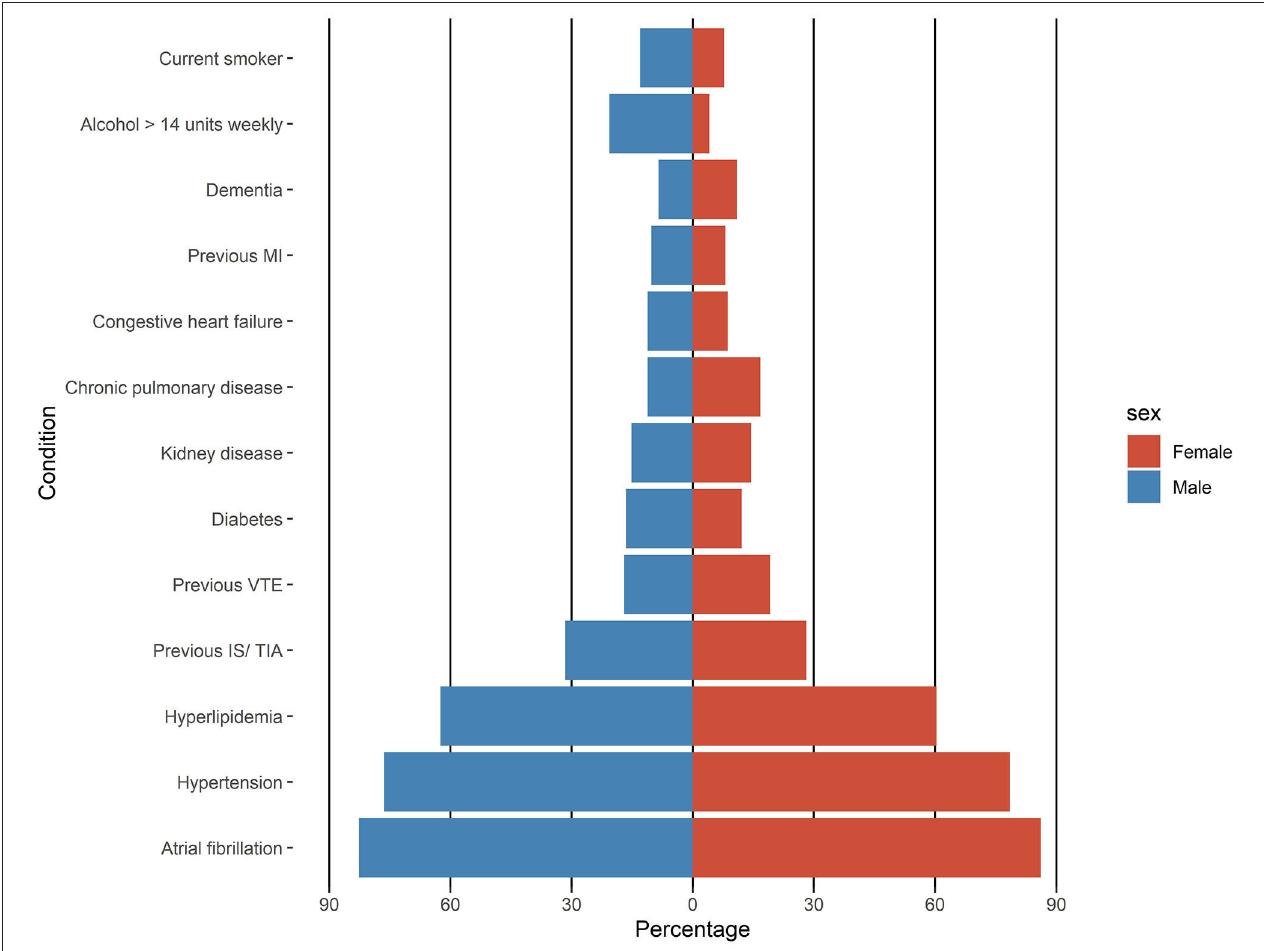
FIGURE 3 | Baseline risk factors in men and women with oral anticoagulant-related intracerebral hemorrhage. MI, myocardial infarction; VTE, venous thromboembolism; IS, ischemic stroke; TIA, transient ischemic